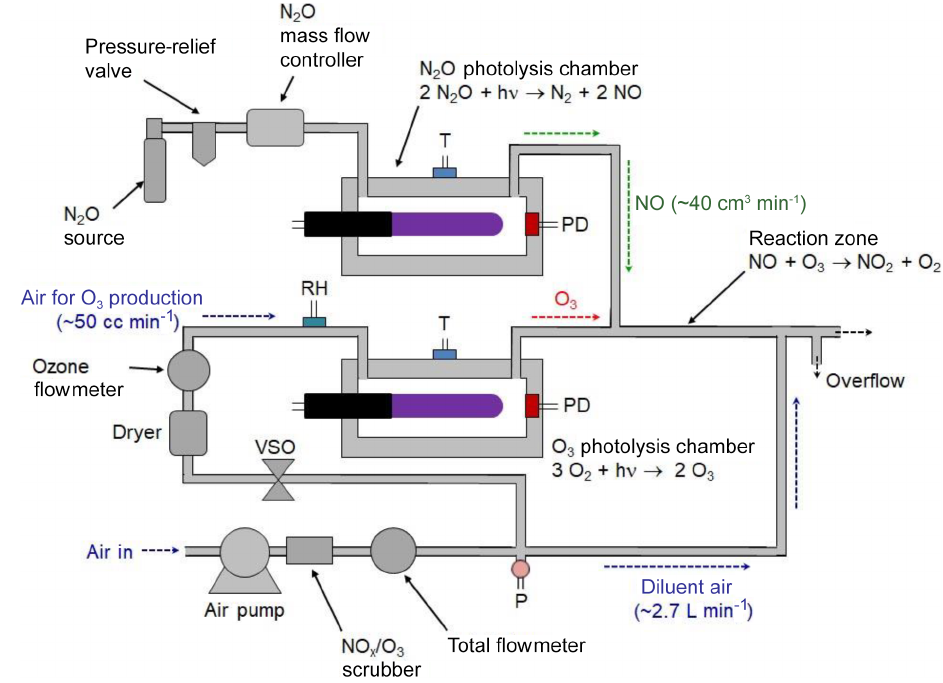
Figure 3. Schematic diagram of the 2B Technologies Model 714 NO 2 / NO / O 3 Calibration